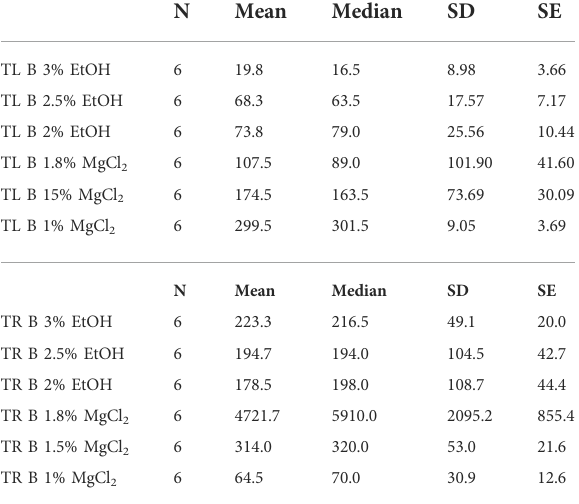
TABLE 3 Time until loss of buoyancy in seconds (TL B) and time to recovery of buoyancy in seconds (TR B) of L. vulgaris embryos exposedtodifferentEtOHandMgCl 2 concentrationsandthecontrols (no anesthetic solution). Measures are summarized (mean, median, SD, and